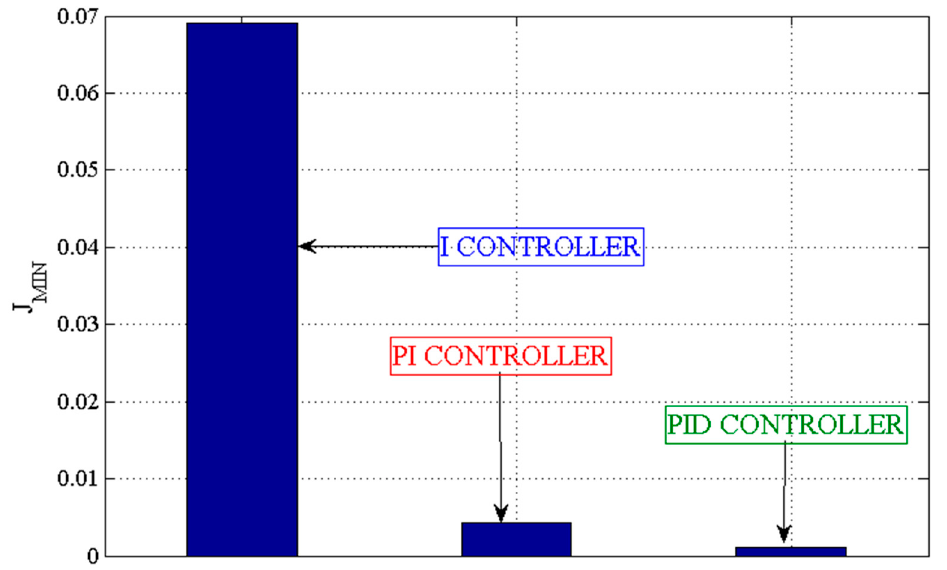
Figure 10. J MIN analysis of I, PI, and PID controllers.